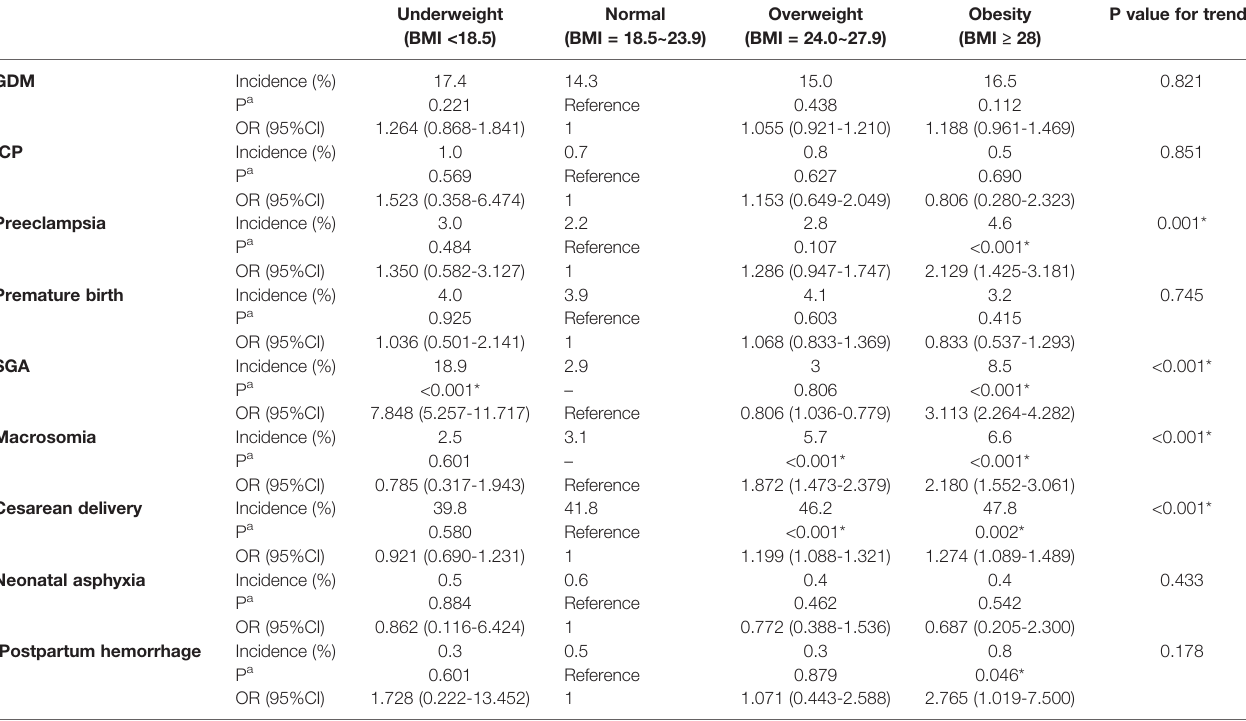
TABLE 2 | Univariate logistic regression comparing pregnancy outcomes in different paternal BMI groups by using forward stepwise.